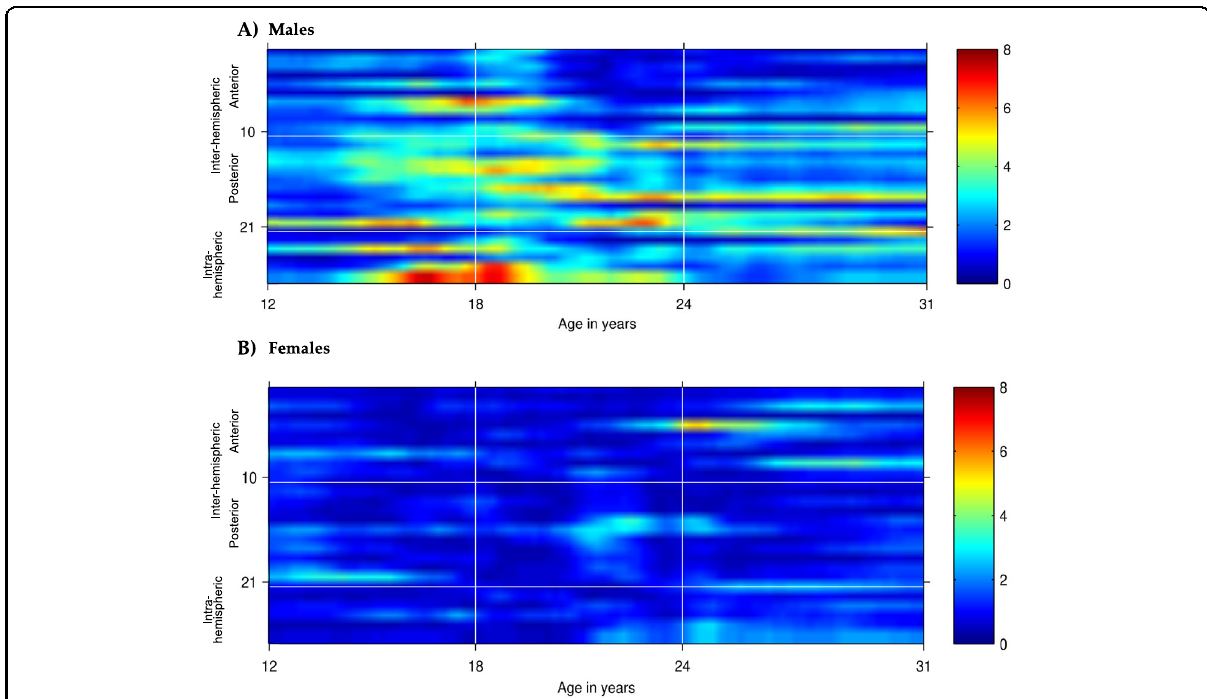
Fig. 2 Association of SCZ PRS with interhemispheric and intrahemispheric high-alpha (9 – 12 Hz) EEG coherence networks in males (A) and females (B) from ages 12 – 31. Age is represented on the x -axis and coherences are represented on the y -axis, with numbering 1 – 27 corresponding to coherences between bipolar electrode pairs illustrated in Fig. 1. Regional divisions are marked with horizonal white grid lines: 1 – 10 anterior (frontal-central); 11 – 21 posterior (central-parietal-occipital); 22 – 27 left and right/anterior and posterior intrahemispheric. Color values in the main panels indicate levels of signi fi cance ( p -values on a negative log 10 scale) as indicated by the color bars on the